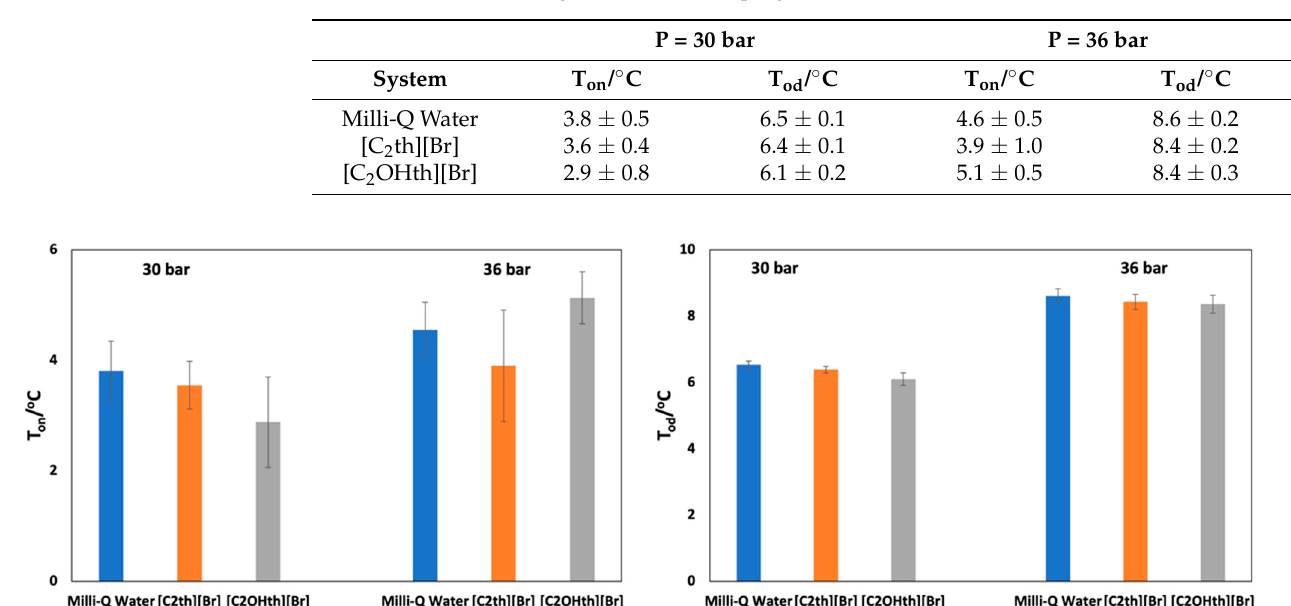
Figure 4. Plots of nucleation (T on ) ( left ) and decomposition (T od ) ( right ) onset temperatures for CO 2 hydrates in Milli ‐ Q water and 1 wt% aqueous ionic liquids solutions at 30 and 36 bar. The error bars represent the standard deviations.